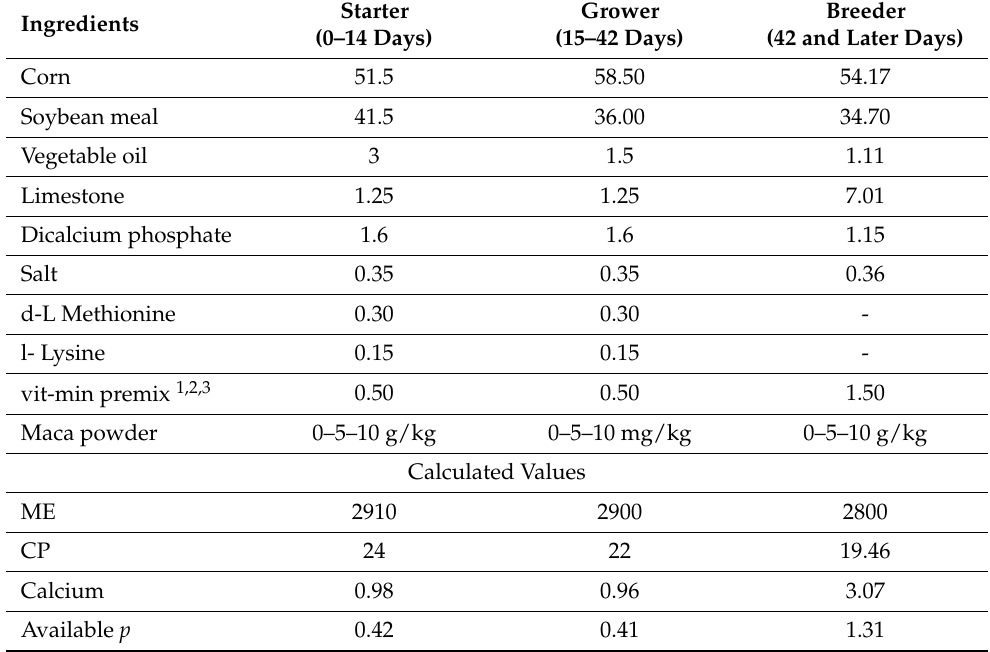
Table 1. The nutritional compositions of diets for the chick rearing period (0–14 days), growing